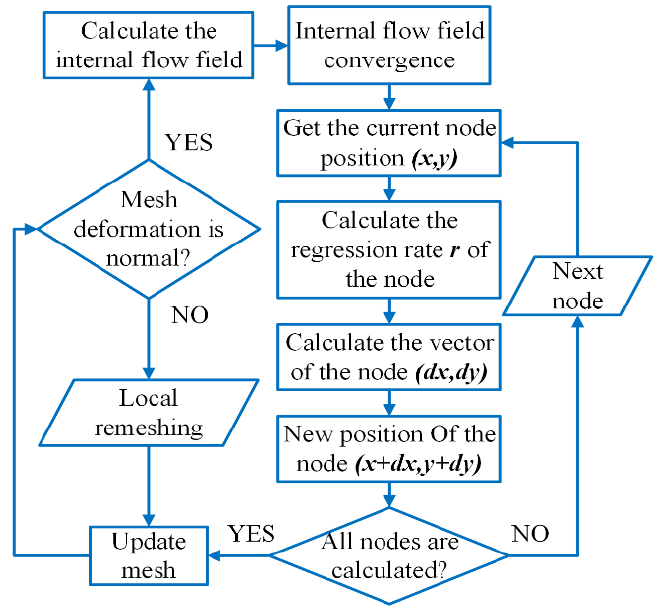
Figure 4. Dynamic mesh update process.